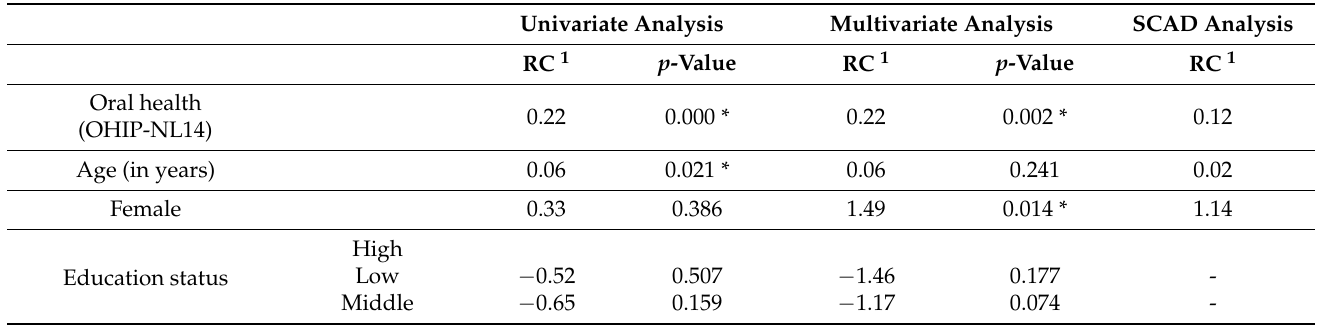
Table 4. Univariate, multivariate, and SCAD analysis for the association between oral health and frailty.